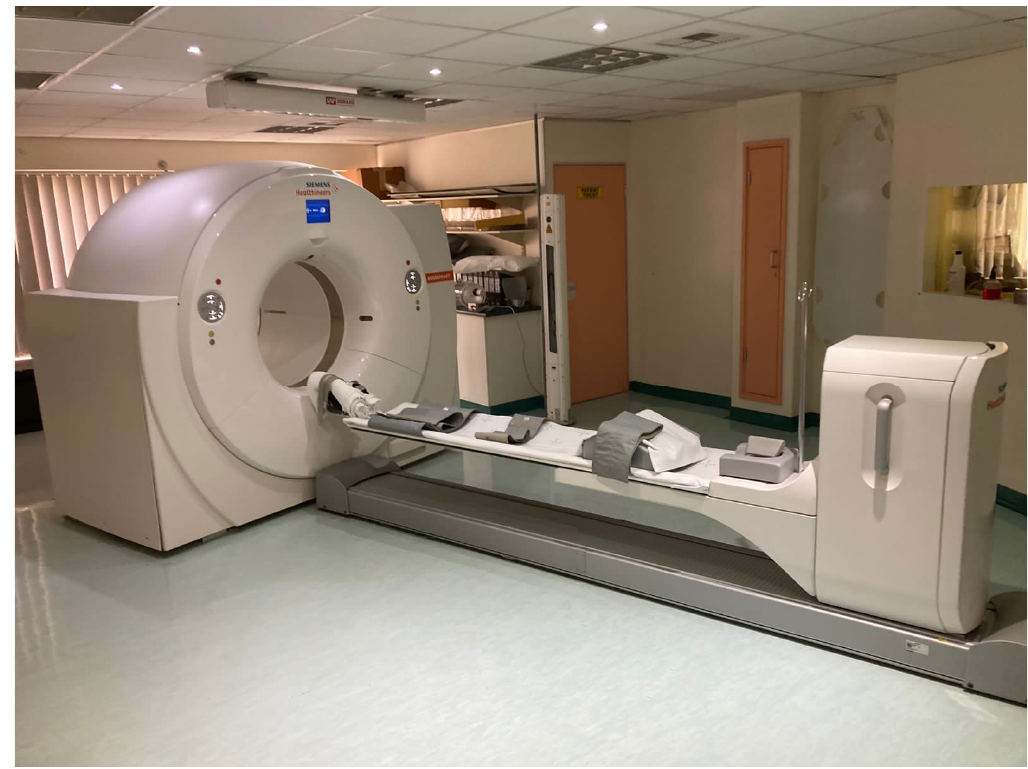
Figure 1. PET/CT with capacity of radiotherapy treatment planning; anatomical and metabolic images are acquired with the patient in the same position.